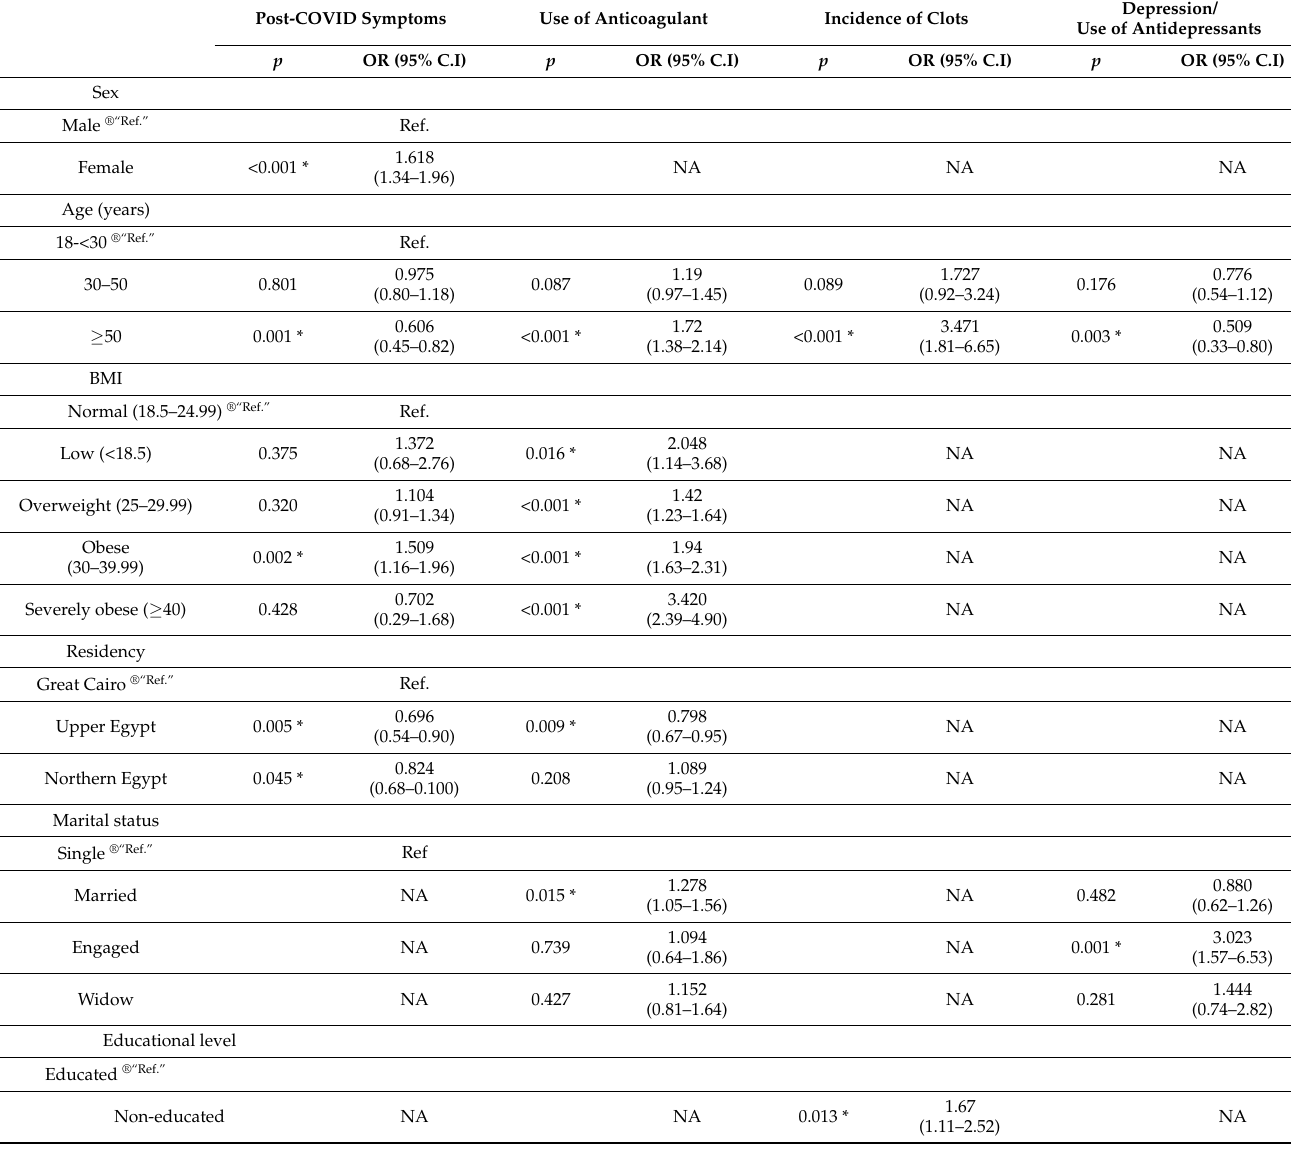
Table 6. Results of multivariate logistic regression between the sociodemographic factors and post COVID-19 symptoms, use of anticoagulant, the incidence of clots, and neuropsychiatric depression symptoms that required antidepressant